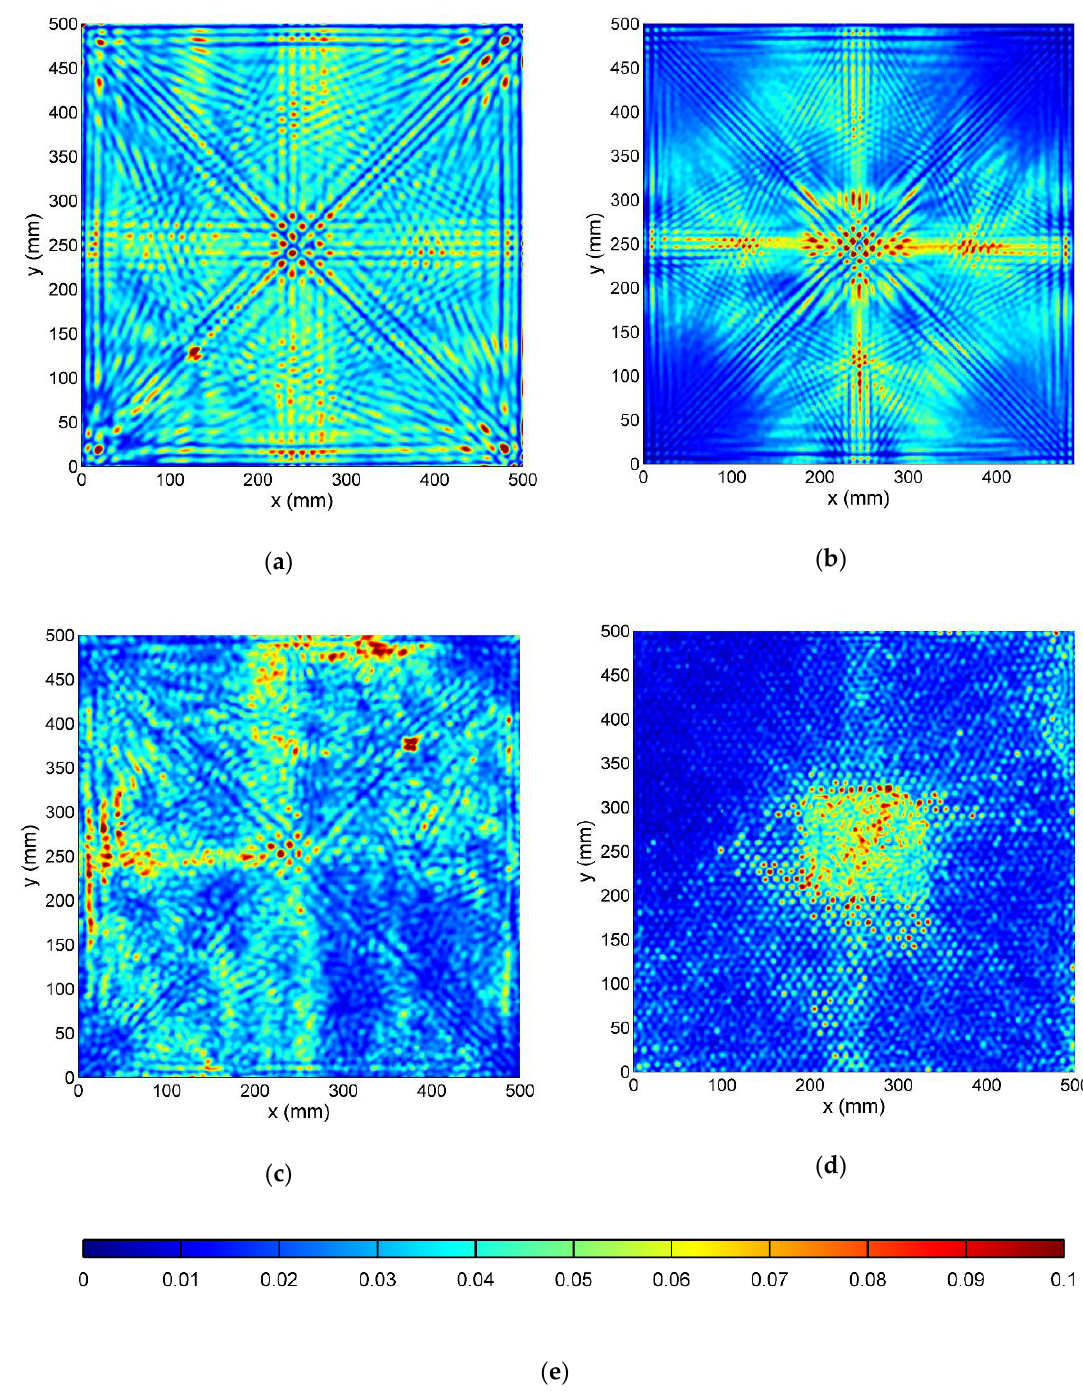
Figure 8. Attenuation-compensated RMS maps for: ( a ) CFRP; ( b ) GFRP; ( c ); SFRP ( d ); HCSP specimen; ( e ) Color scale.